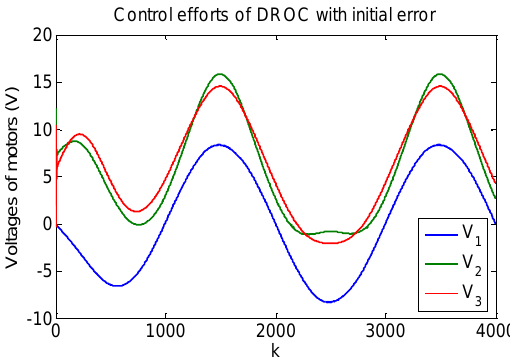
Figure 5. Control efforts of DROC with Initial